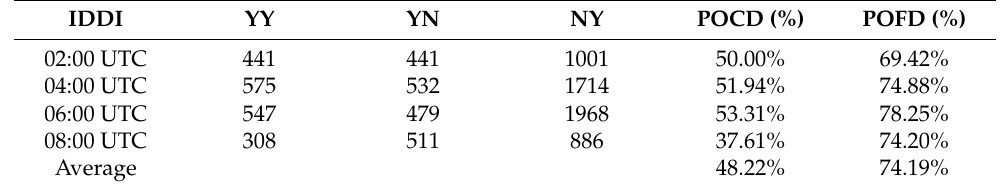
Table 5. Statistical metrics for the comparison of the IDDI dust identification and the PM10 observations.